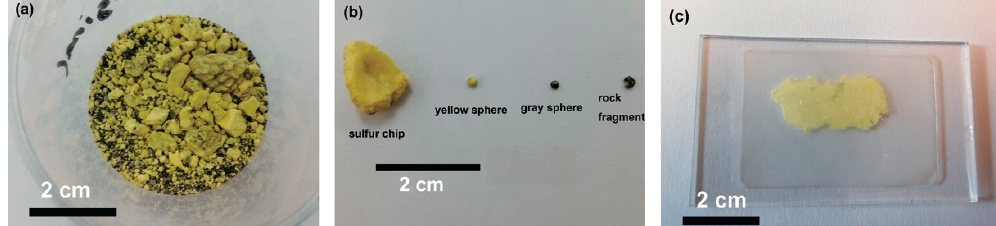
Figure 2. Photographs of native sulfur. ( a ) Native sulfur sample collected from a high-temperature vent; ( b ) Different sulfur aggregates and a rock fragment enclosed in native sulfur that were picked from the native sulfur samples; ( c ) Thin section of a sulfur chip.